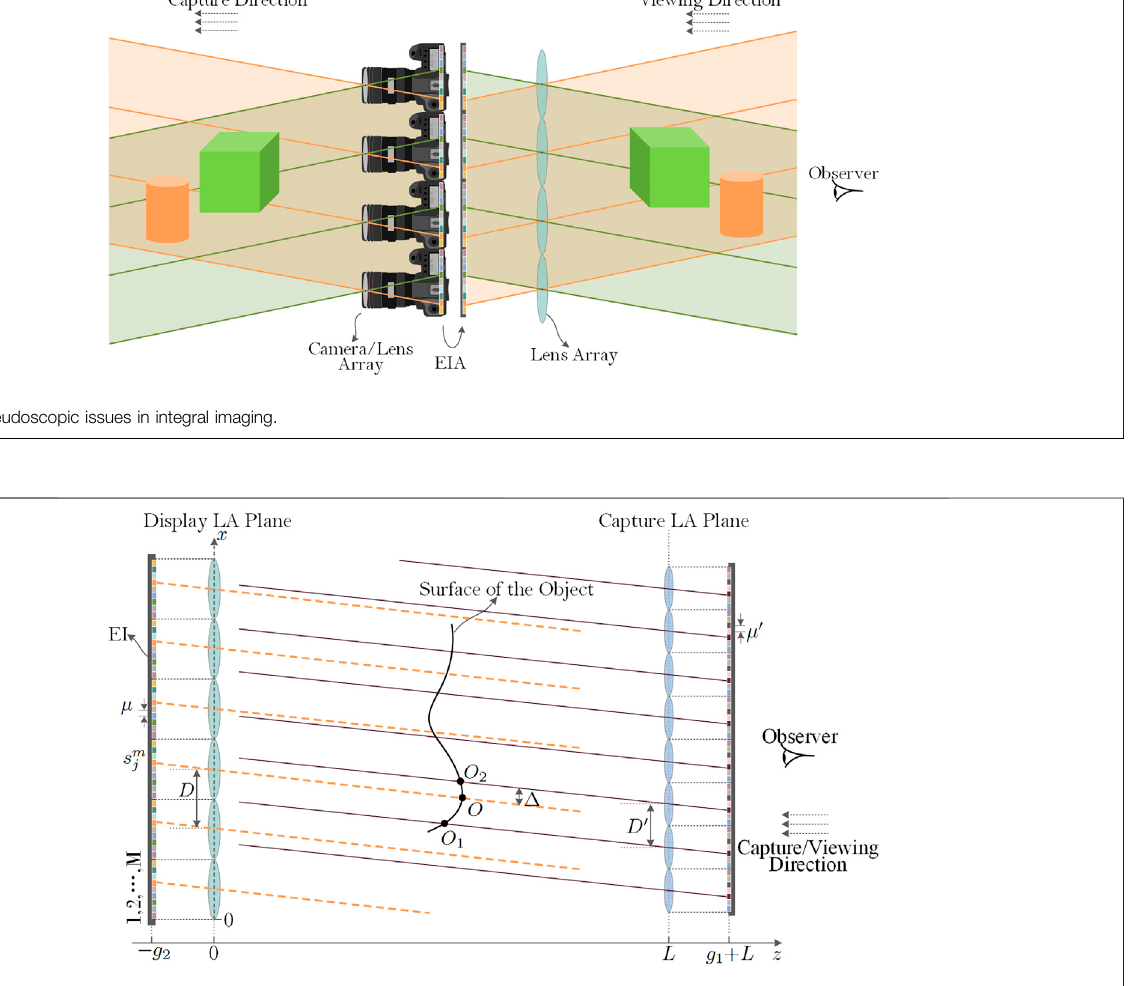
FIGURE 2 | The relationship between capture and display